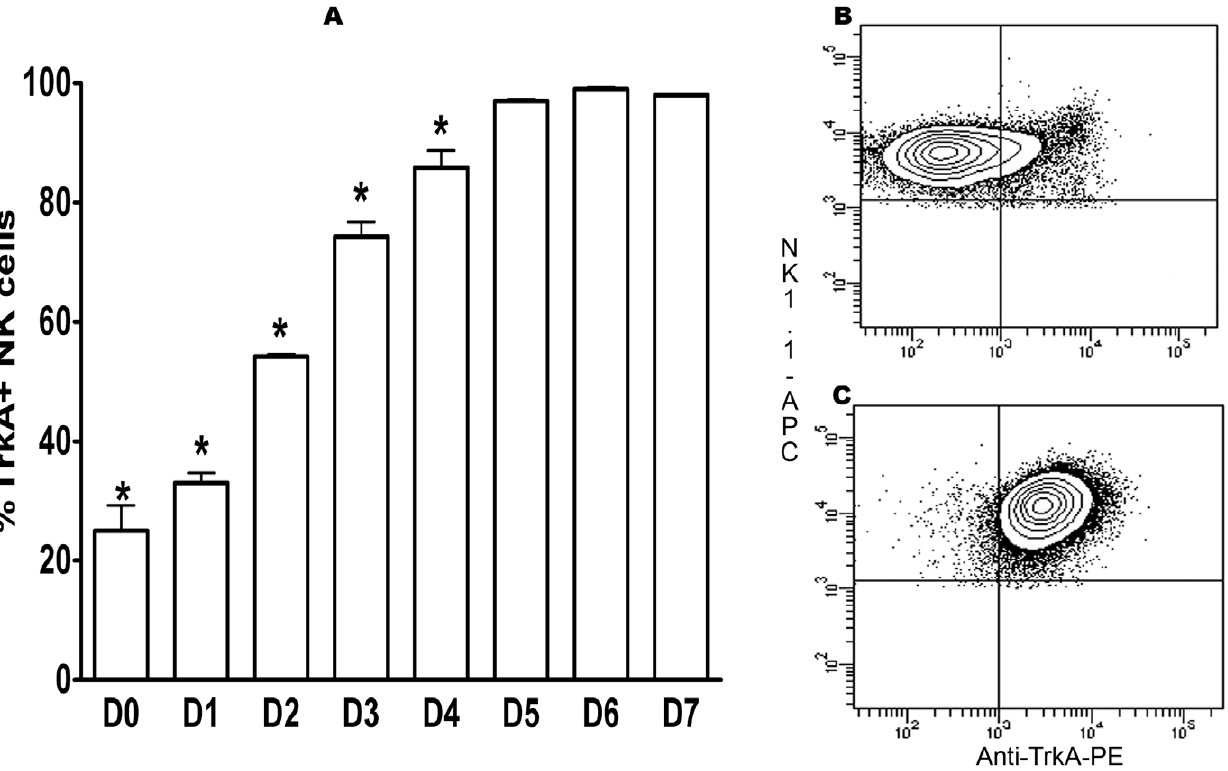
Figure 2. Kinetics of the expression of the high affinity NGF receptor TrkA on mouse NK cells. Splenocytes were stained with anti-NK1.1, anti-CD3 and anti-TrkA Ab or isotype control as described in Materials and Methods, and analyzed by flow cytometry. Dead cells were excluded by staining with Live Dead cell marker. A gate was set on NK cells (CD3-NK1.1 + ), and the percentage of TrkA + NK cells was determined. A: kinetics of TrkA expression from day 0 to day 7 (culture in the presence of IL-2). The data shown are the means 6 SEM of three experiments. *: p , 0.05: B: TrkA expression on fresh splenic NK cells represented as contour plot. Data shown are from one representative experiment out of three performed. C: TrkA expression on day 5 of culture with IL-2 represented as contour plot. Data shown are from one representative experiment out of three performed.